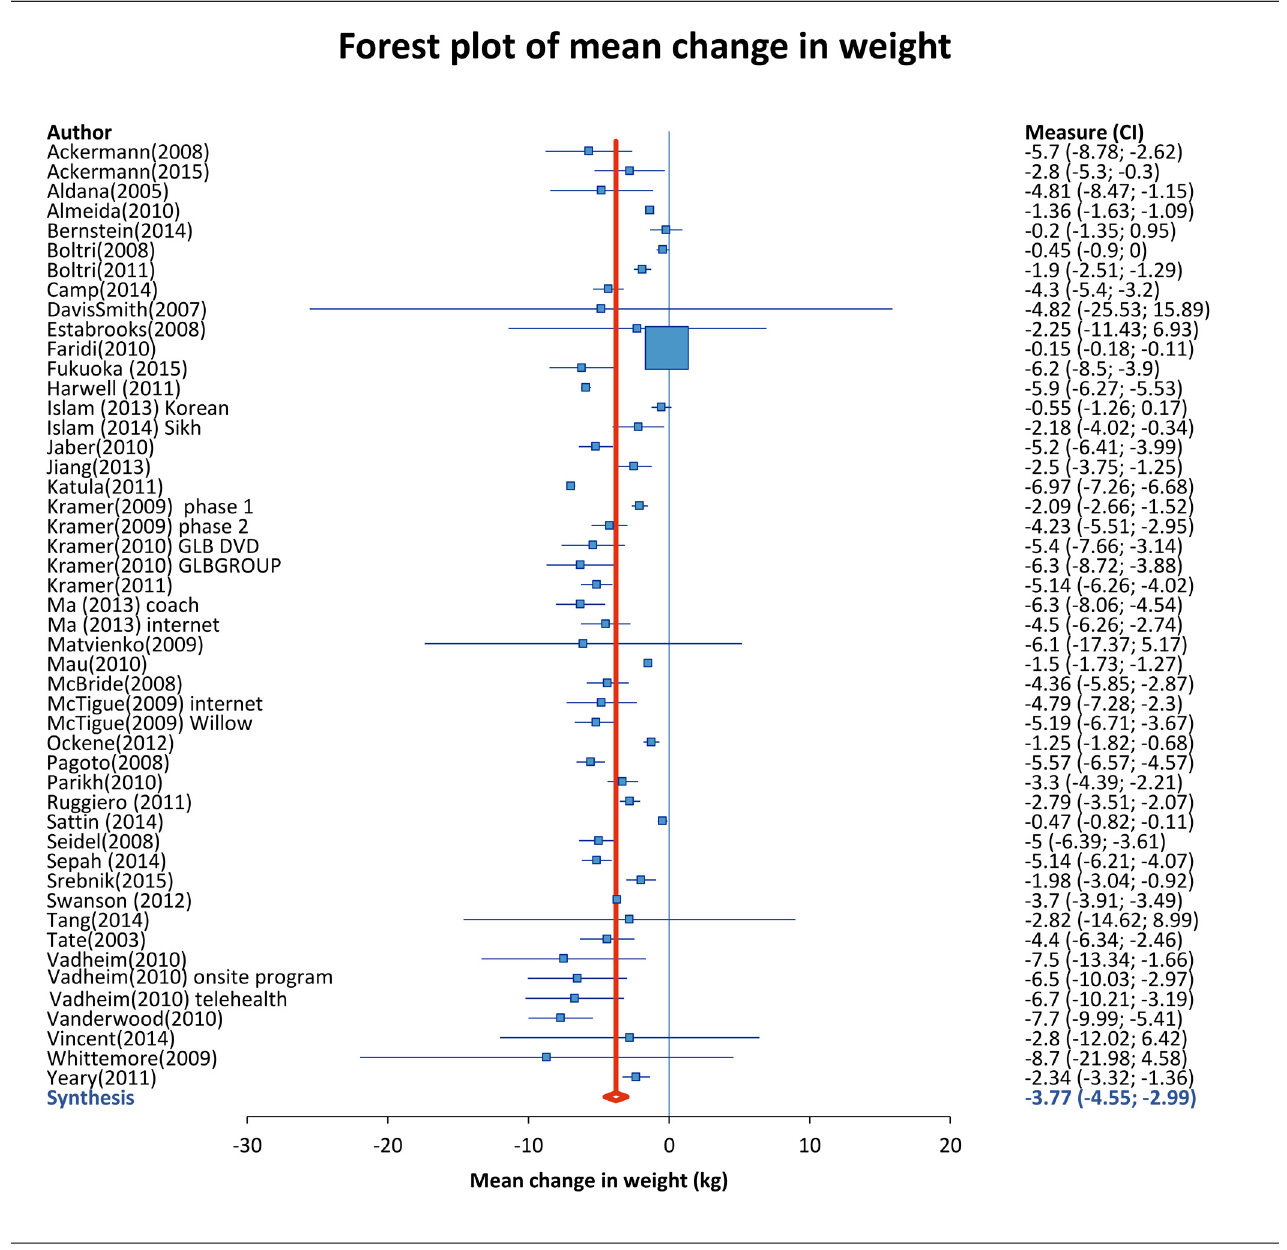
Fig 2. Mean weight change of study participants. Analysis of all 48 intervention groups which reported weight change from baseline to end of follow-up period. Data was analyzed with Mix 2.0 using random effects method with the weighting of each study proportional to the inverse of the variance. Study weight is indicated by the size of the box, and horizontal lines indicate the 95% confidence interval. The red line indicates the overall weight change, and summary diamond indicates pooled estimate with reported mean (95%